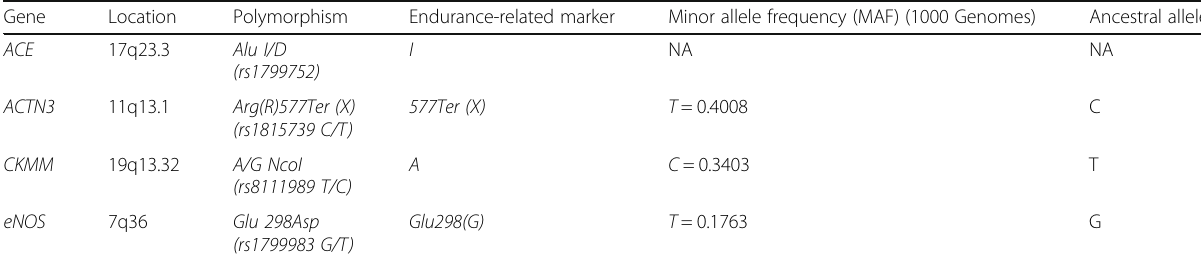
Table 2 Gene variants studied for endurance status